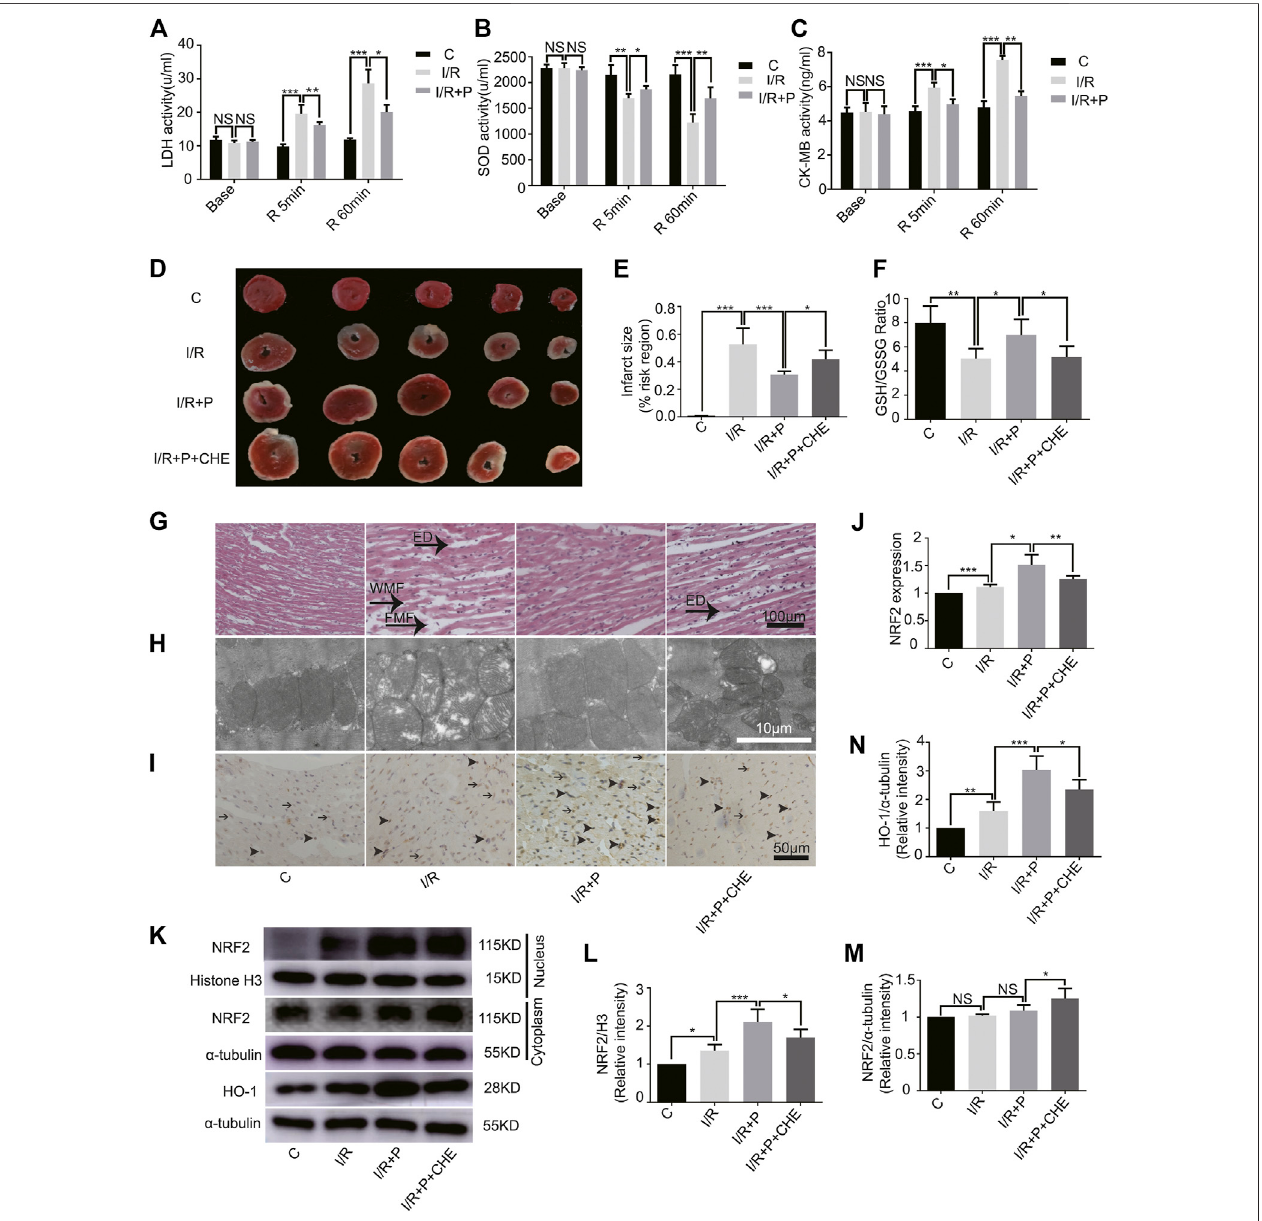
FIGURE 5 | Effect of propofol on I/R-induced myocardium injury. Expressions of LDH ( A) , SOD ( B) , and CK-MB ( C) in the coronary perfusate. The perfusate was collected before ischemia (base) and reperfusion for 5 min (R 5 min) and 60 min (R 60 min). (D,E) : Myocardial infarction areas were measured by triphenyltetrazolium chloride(TTC)staining. (F) .GSH/GSSGchangesinmyocardium. (G) .Structuralchangesinmyocardial fi bersbasedonHEstaining.ED(edema),WMF(wavymyo fi bers), andFMF(faultedmyo fi bers).Thescalebaris100 µm. (H) .Mitochondrialchangesunderelectronmicroscopy.Thescalebaris10 µm. (I,J) .TheexpressionofNRF2 in myocardium based on immunohistochemistry assay. The arrowhead represents nuclear expression of NRF2, and the arrow represents cytoplasmic expression. The scale bar is 100 µm. (K – N) . Expressions of NRF2 and HO-1 in myocardium based on the western blot assay. N (cid:1) 6. The data are expressed as the mean ± SD. Signi fi cance was calculated using two-way ANOVA with Bonferroni ’ s correction. p < 0.05 was considered statistically signi fi cant. * p < 0.05, ** p < 0.01, *** p <